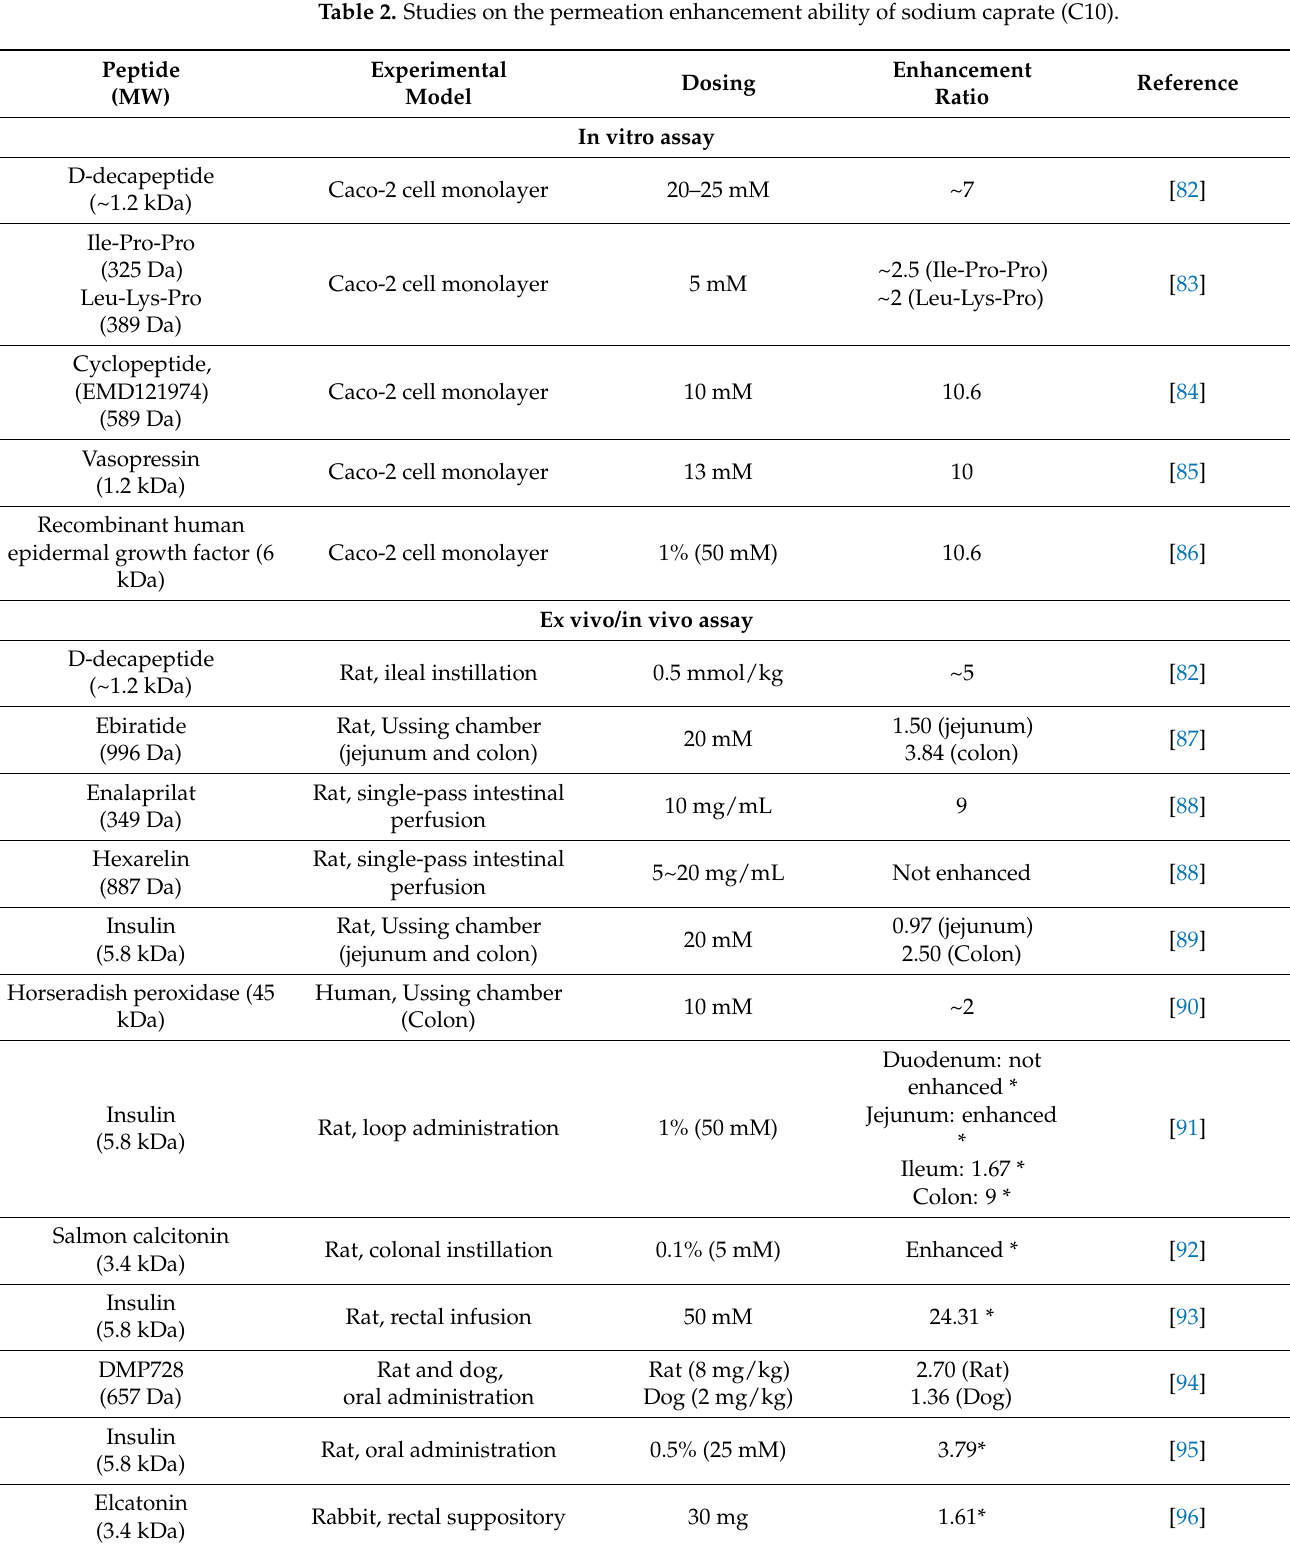
Table 2. Studies on the permeation enhancement ability of sodium caprate